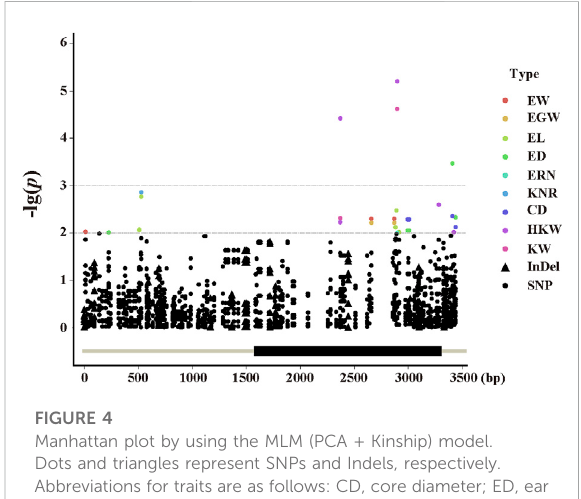
FIGURE 4 Manhattan plot by using the MLM (PCA + Kinship) model. Dots and triangles represent SNPs and Indels, respectively. Abbreviations for traits are as follows: CD, core diameter; ED, ear diameter; EGW, ear grainweight; EL, earlength; ERN,ear row number;EW,earweight;HKW,hundredkernelweight;KNR,kernel number per row; KW, kernel width.